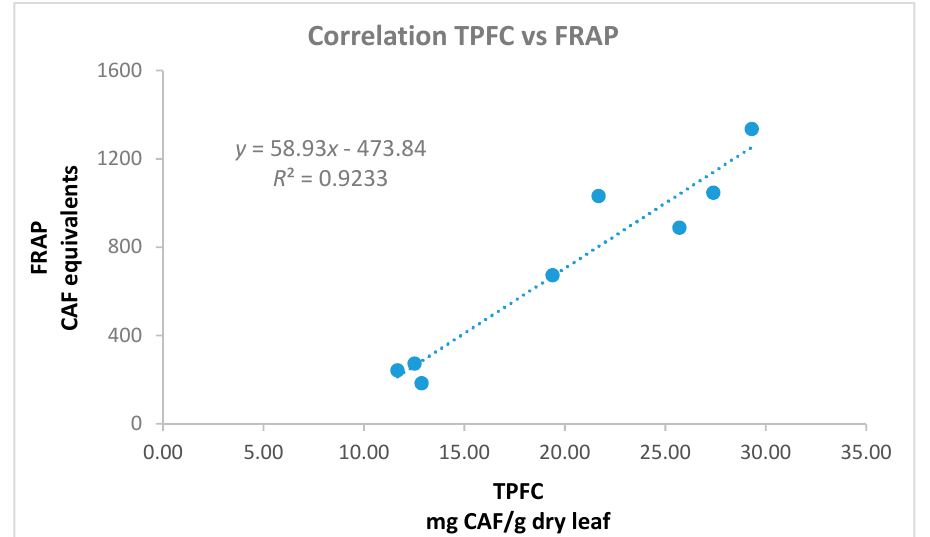
Figure 7. Correlation of total phenols determined via the Folin-Ciocalteu assay (TPFC, mg CAF/g dry leaf) and ferric reducing capacity (FRAP, mg CAF/L ) data of the aqueous olive leaf extracts.